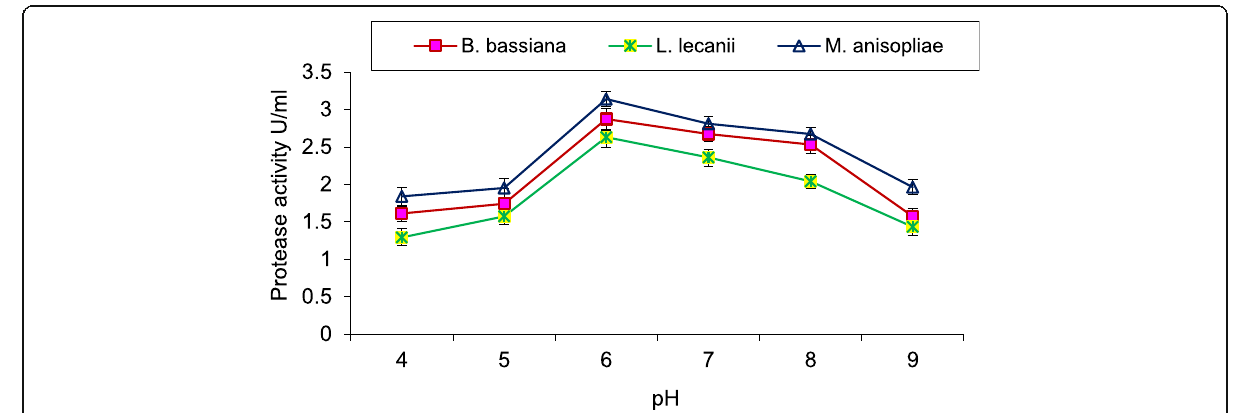
Fig. 5 Effect of pH on protease activity of the EPF isolates of Beauveria bassiana , Lecanicillium lecanii , and Metarhizium